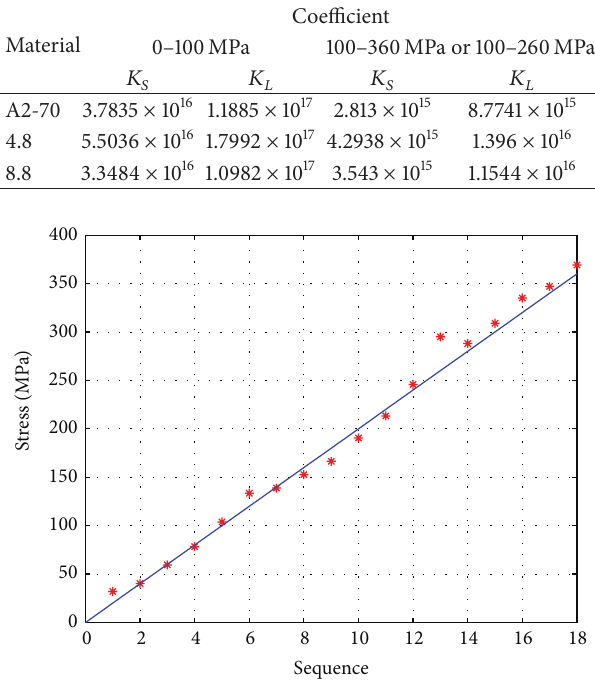
Figure 3: The comparison result of an A2-70 austenitic stainless steel bolt.